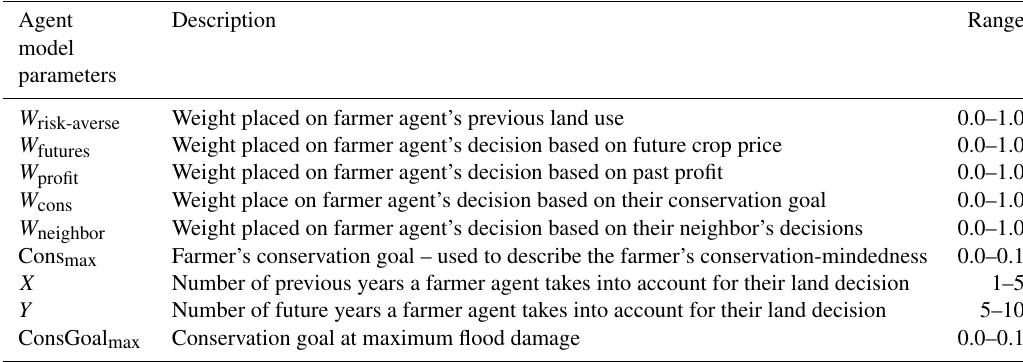
Table 2. Primary agent model parameters in decision-making equations.